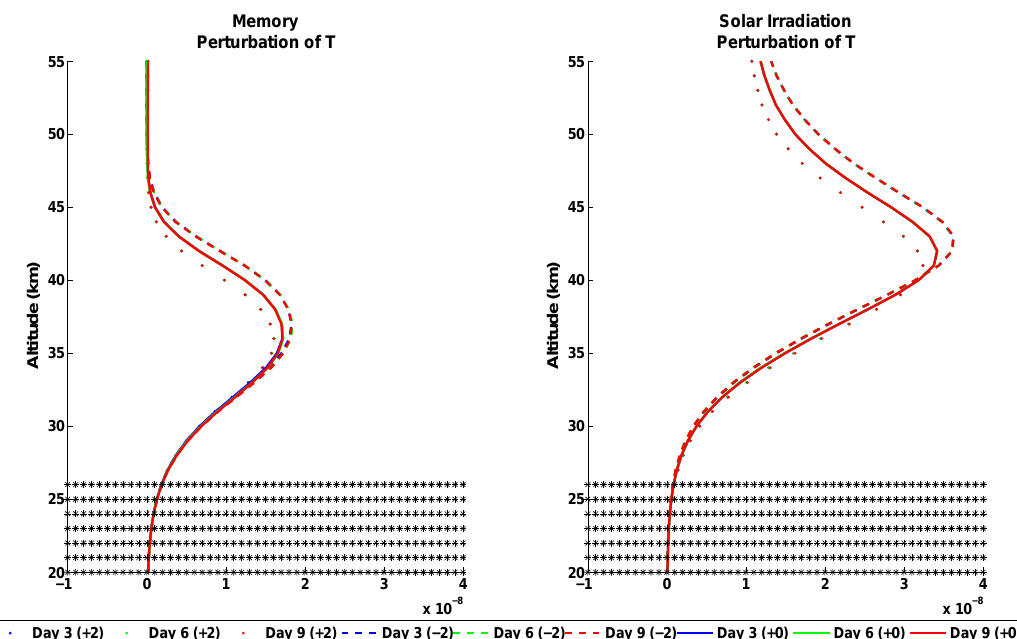
Fig. 6. Sensitivity to temperature of the non-normalised regression coefficients for the memory β 0 (left) and current day’s solar irradiance γ 0 (right) for the 3-predictor model. The solid line repeats results from the regular simulation (Fig. 5), and the dashed and dotted lines are for a temperature perturbed with minus and plus two standard deviations, respectively (see Fig. 1). Different colours indicate different simulation days. Note that the previous day’s solar irradiance coefficient (not shown) has a similar sensitivity to temperature as the current day’s solar irradiance, and that the 2-predictor model’s coefficients (not shown) have a similar sensitivity to the corresponding ones in the 3-predictor model. Regions where the standard deviation (amongst the ensemble) in the observed variable y was smaller than 5% of the maximum standard deviation in the column are hatched